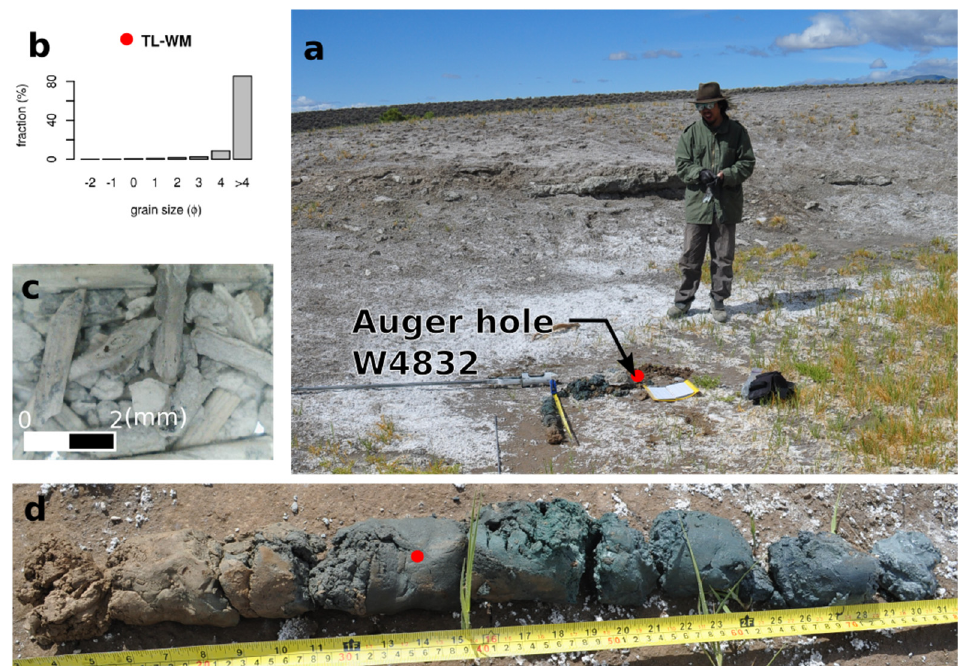
Figure 9. ( a ) Looking west toward sandstone ridge (distant vegetated ridge) from depression D1. Auger hole for the TL sample W4832 is in loose sediment in the depression floor (red dot). Sinter outcrop is visible halfway up the rim around the central depression. Sinter surrounding the depression is blanketed with loose fine-grained sediment. ( b ) Grain size analysis for the sediment sample collected from 20 cm below the surface, and immediately above the TL sample. ( c ) Root fragments and silica sinter from the coarse portion of sediment collected from the surface of D1. ( d ) Reconstructed soil column from the auger hole in D1. Surface sediments (left) were loose sand and silt with fragments of sinter and roots. Grain size decreased with depth, while sorting increased. Approximate TL sample depth indicated by the red dot.